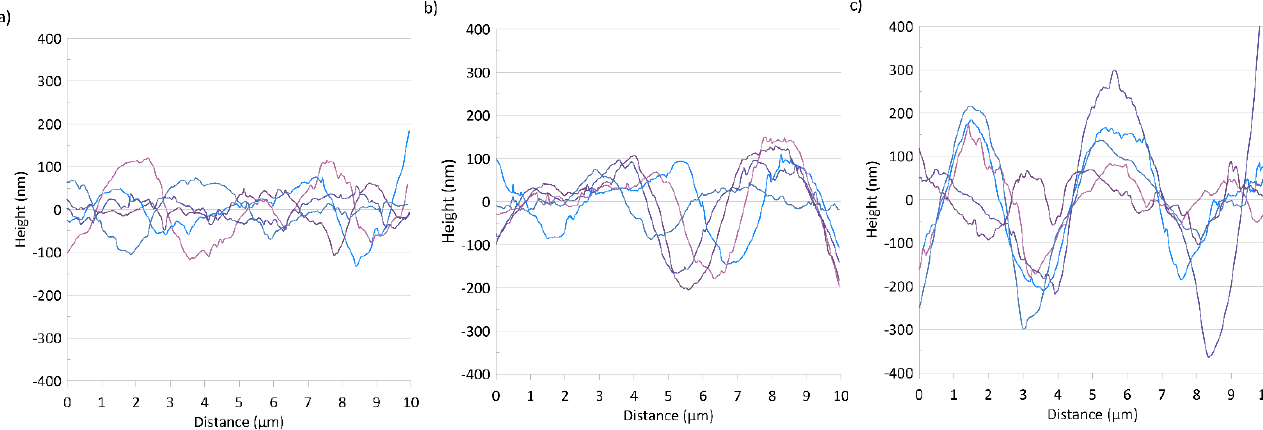
Figure 4. Five representative cross-sections obtained from evenly distributed areas over the entire surface of the films for samples k0 ( a ), k5 ( b ) and k10 ( c ).